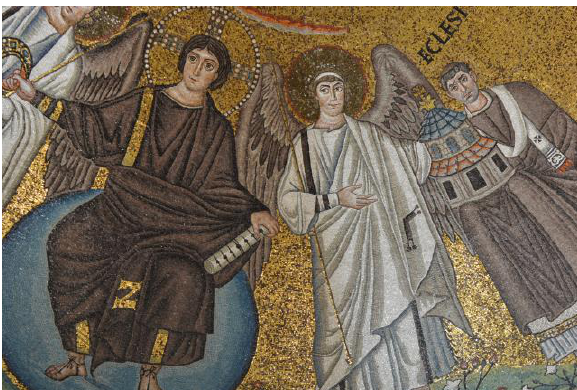
Figure 8. Specular, highly reflective materials are quite difficult to simulate in render engines: stratification of special RGB and greyscale texture is needed to specify BRDF.